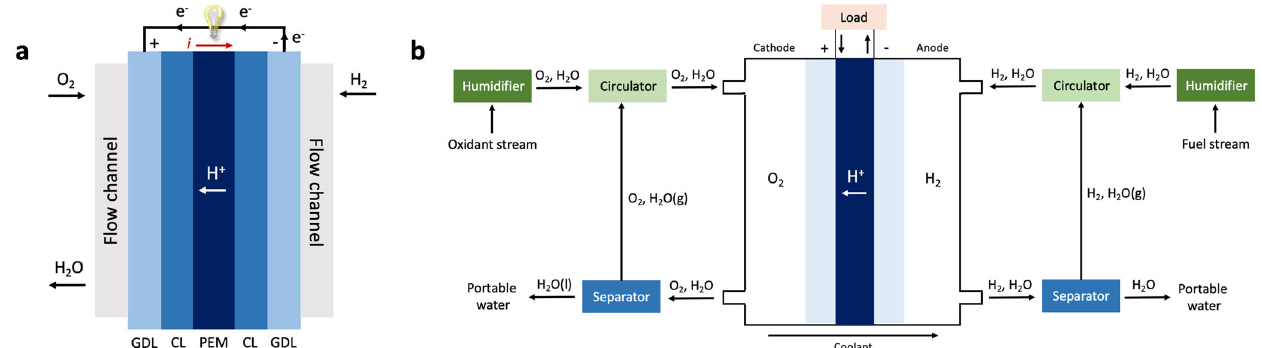
Fig. 3 Scheme of a PEM-based fuel cell. a Scheme of a PEM (proton exchange membrane)-based fuel cell. GDL is the gas diffusion layer and CL the catalyst layer. b Extended scheme of a conventional PEMFC with an active fl uid supplement system, comprising the fuel cell, gas humidi fi ers, an active circulation, and phase separation subsystem. Redrawn from Guo et al. (2017) 3